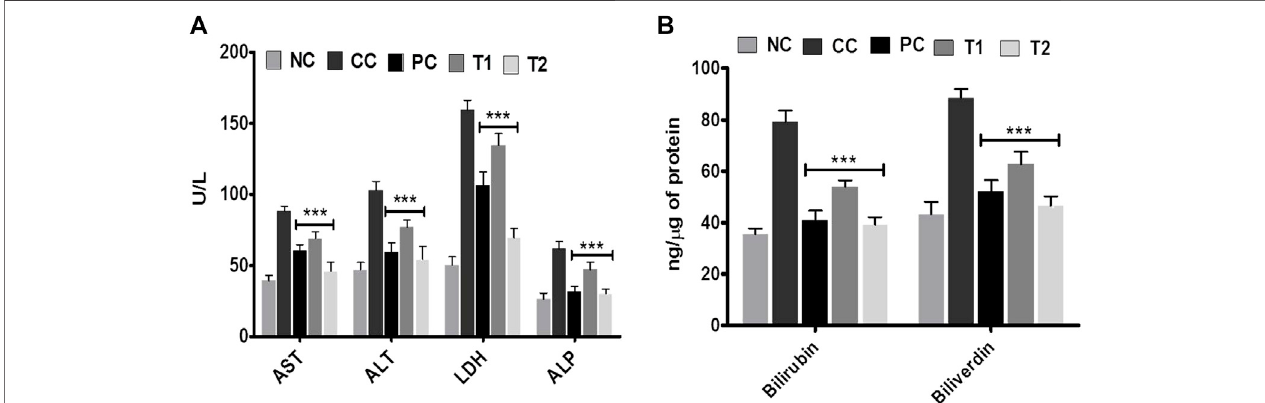
The data are provided as mean ± SD (n (cid:1) 8). Between the CC and test groups statistically signi fi cant differences were found [one-way ANOVA, followed by the Bonferroni multiple comparison test] (* p < 0.05), ** p < 0.01 and *** p < 0.001)].